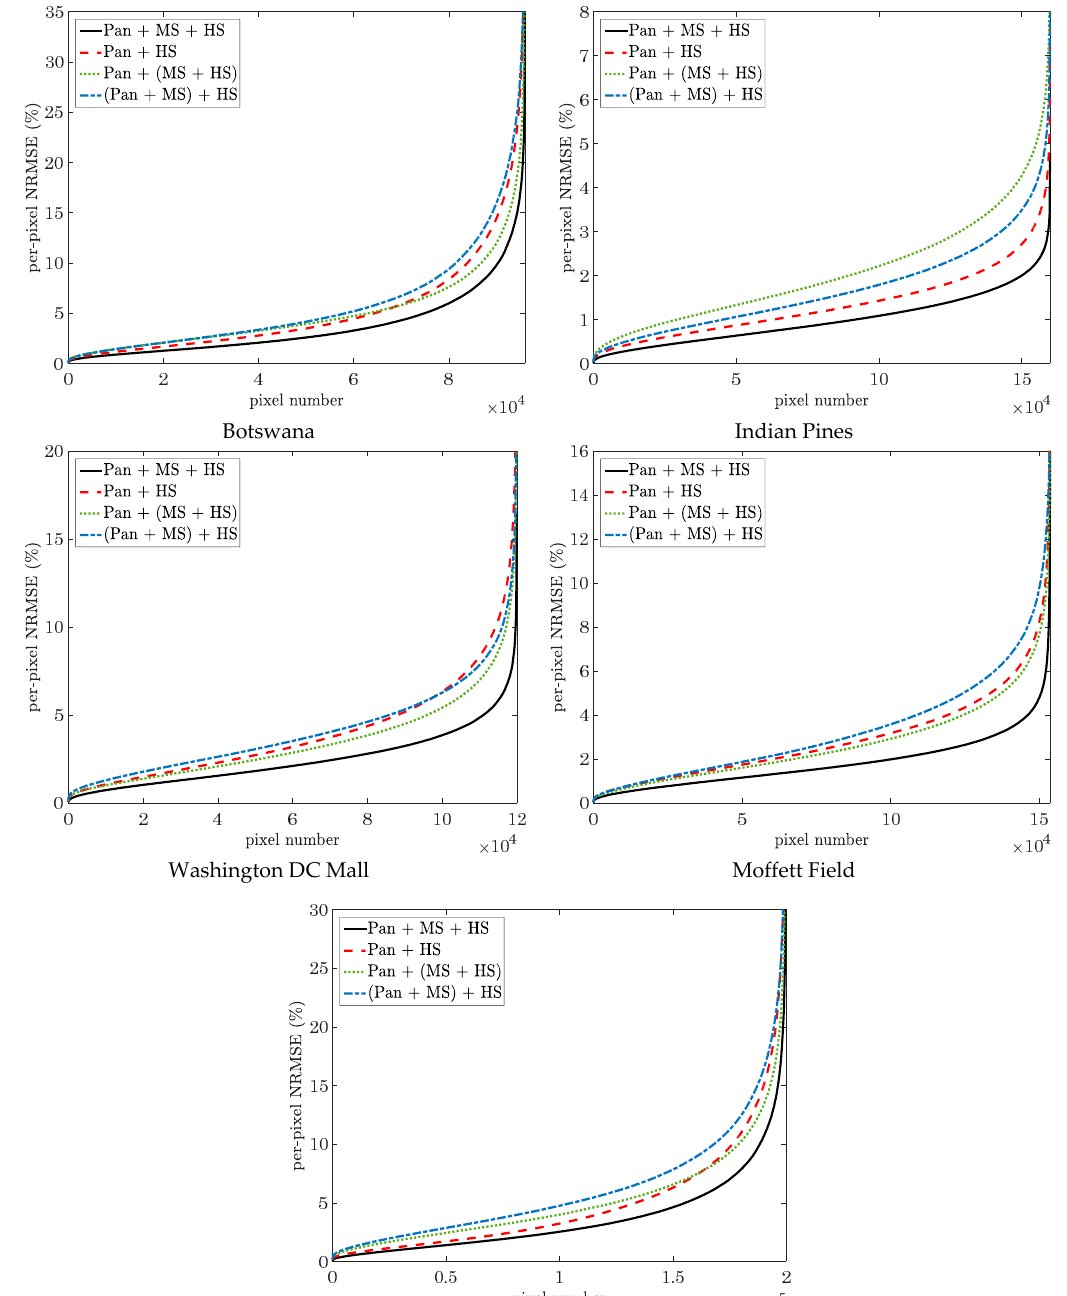
Figure 4. The sorted per-pixel NRMSE of different algorithms measured only on the spectrum of the panchromatic image in experiments with different images.